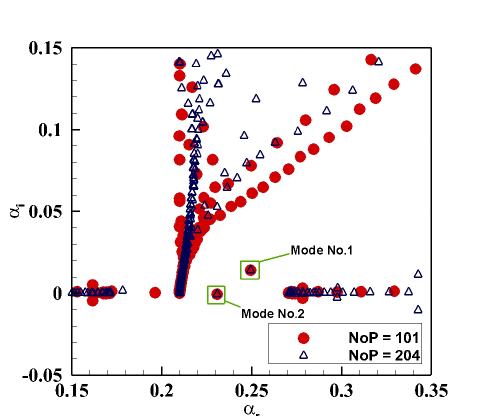
Figure 1. Eigenvalue spectrum and discrete modes computed with two sets of computation grids.